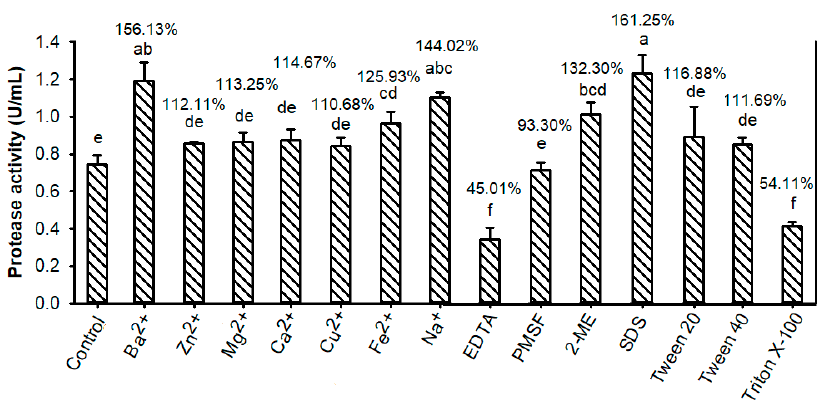
Figure 8. E ff ect of metal ions, protease inhibitors, and surfactants on Paenibacillus sp. TKU047 protease. All points on the graph indicated the mean of each experiment (with n = 3) and standard deviation (error bar). Di ff erent letters (a, b, c, d, e, and f) indicate significant di ff erence based on Tukey’s test with p < 0.05. The values on top of the bars (%) are the ratios of the residual activities to the protease activity of the enzyme in the phosphate bu ff er